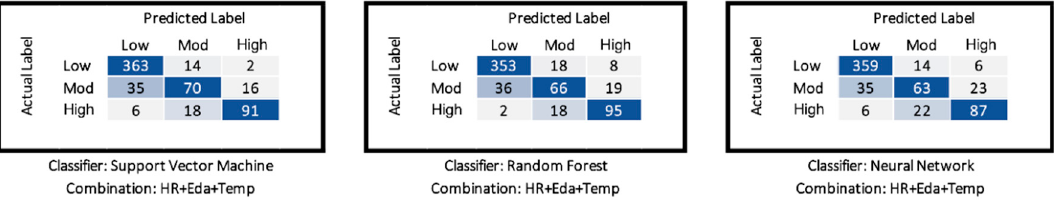
Figure 2. The confusion matrices for the best combinations in each classifier using feature fusion. Abbreviations: Eda = electrodermal activity; HR = heart-rate; Mod = moderate; Temp = temperature.